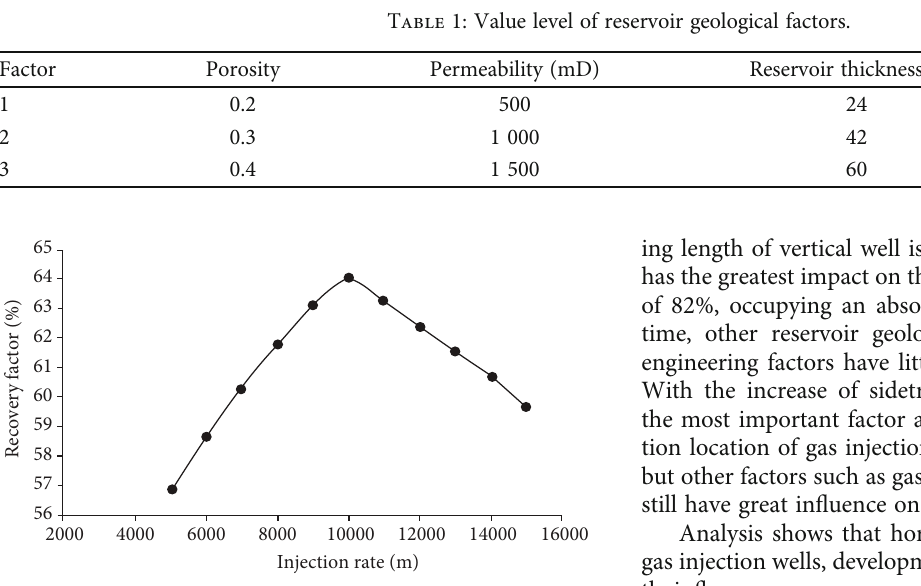
Figure 6: Relationship between gas injection rate and recovery factor.